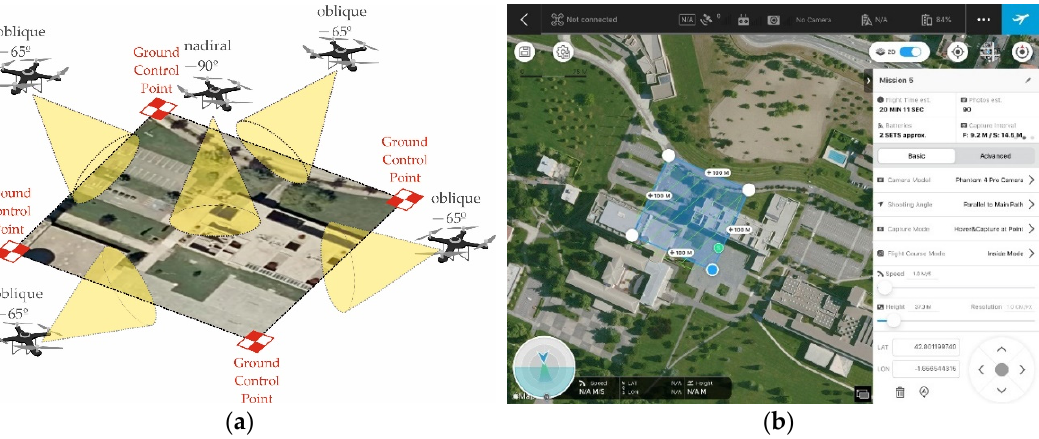
Figure 9. Automatic flight configuration for a surface of 1 ha in the UNAV university campus in Pamplona: ( a ) UAV shots and Gimbal inclinations; ( b ) data in the DJI-GS Pro app. Table 1. Automated flight configuration chart for the coverage of a 1 ha area and with photogram- metric model resolution of 1 cm/pixel.